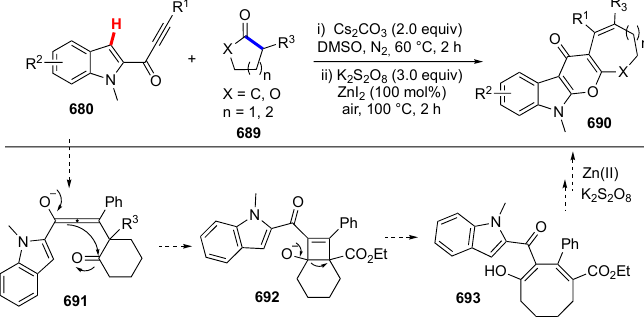
Scheme 89. Base-mediated synthesis of pyranoindolones.